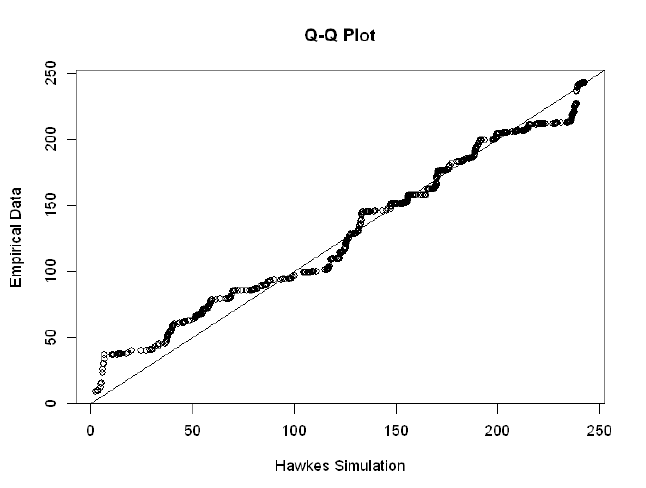
Figure 10. Q-Q plot of arrival time simulated by Hawkes process with parameters and empirical data of Group